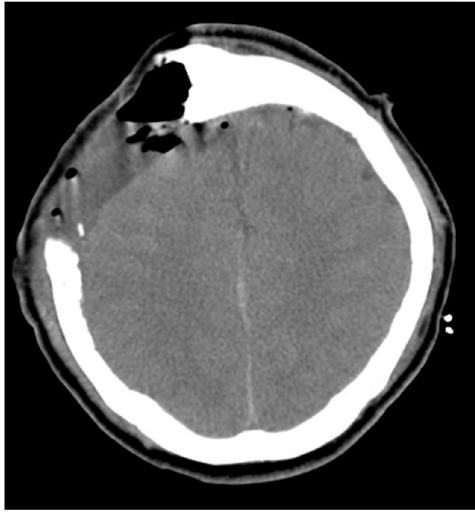
Figure 3. Post-operation brain CT image revealed no hemorrhage, but mild edematous change of the right vertex frontal-parietal lobe.